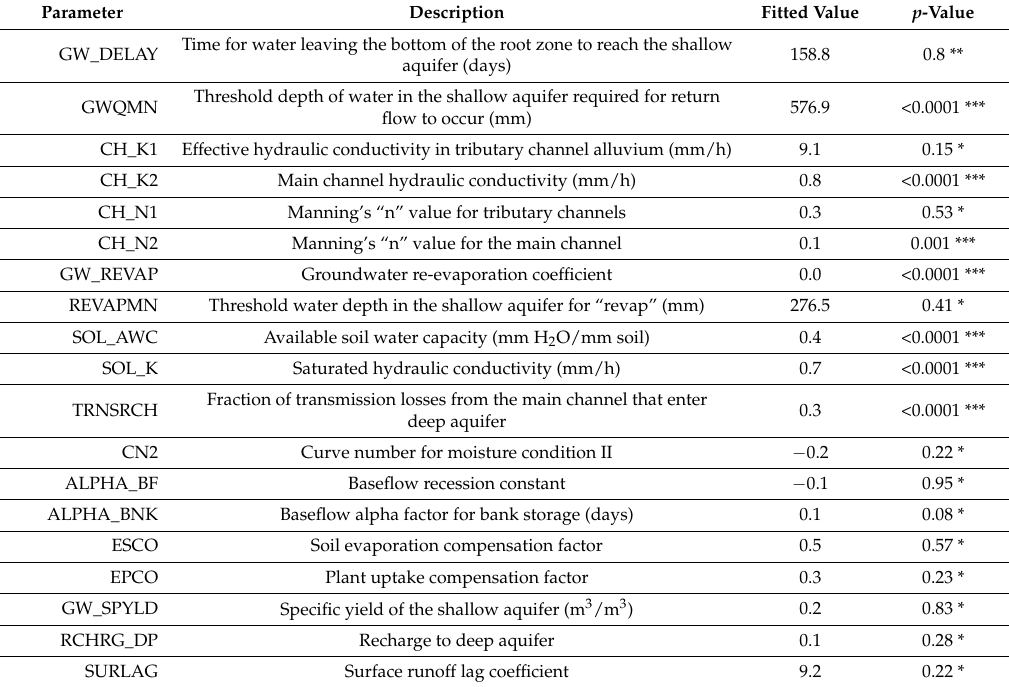
Table 2. Parameters used for the calibration of the SWAT